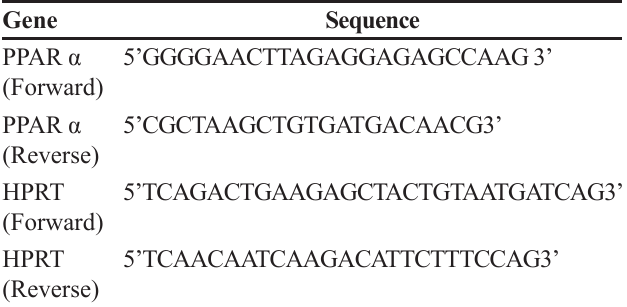
TABLE II - Sequences of probe and oligonucleotides used in real-time PCR analysis